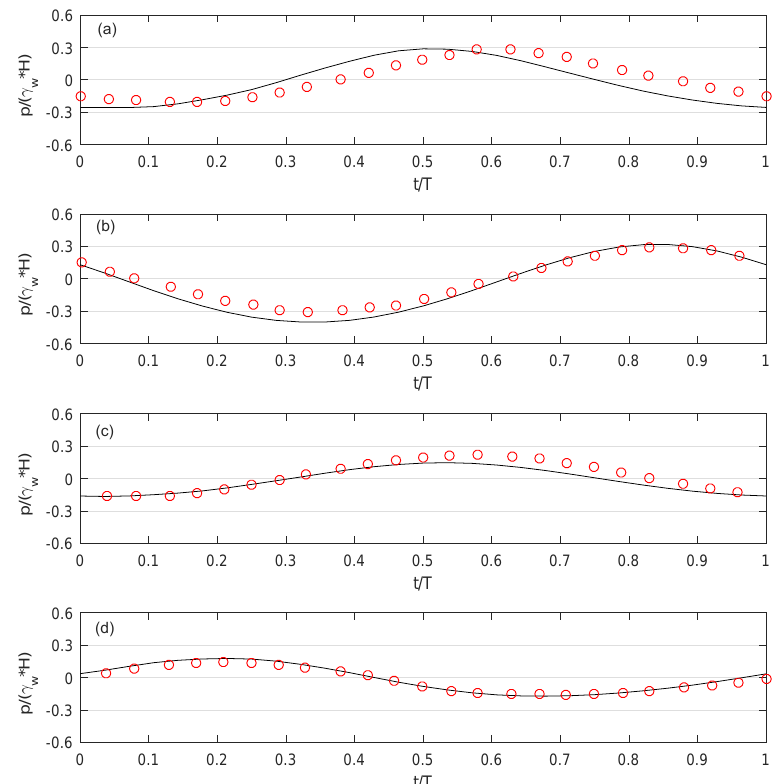
Figure 2. Comparisons of the wave-induced pore pressure with experimental data [48]. ( a ) point A; ( b ) point B; ( c ) point C; ( d ) point D (line: the present model, red circle: experimental data